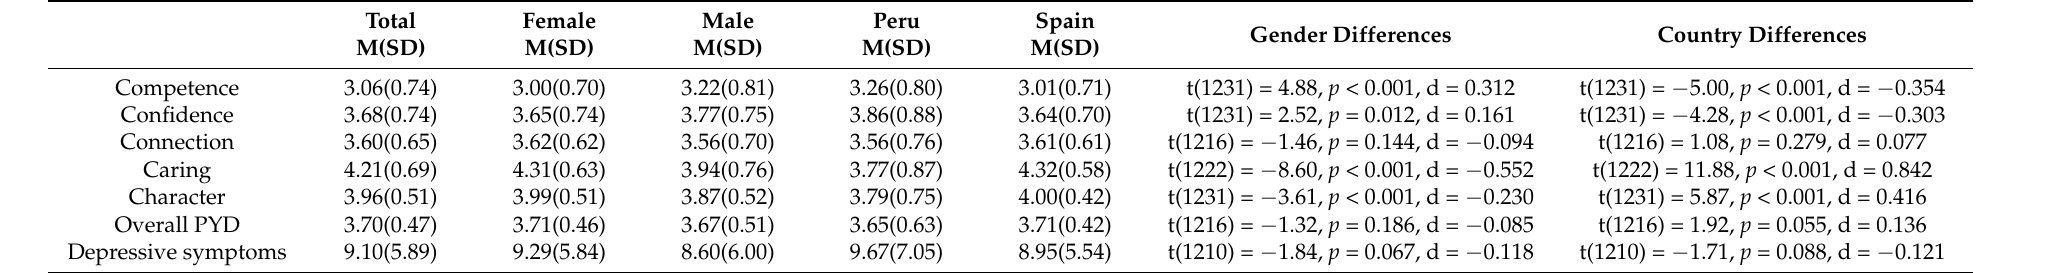
Table 1. Gender and country differences in the 5Cs of PYD and depression symptoms, t-test analysis.